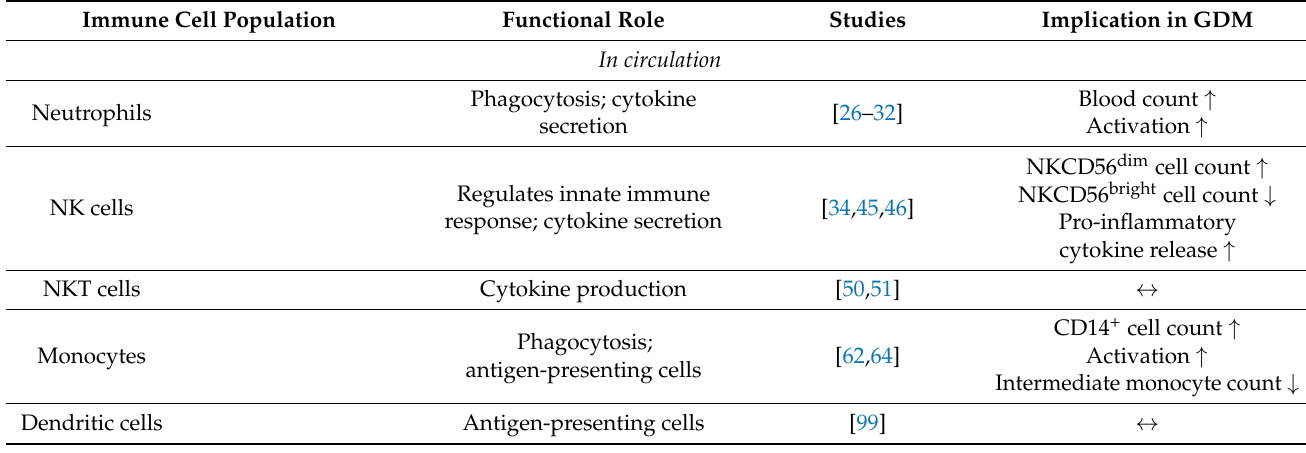
Table 1. A summary of the studies describing immune cell populations in maternal circulation, placental tissue and adipose tissue in GDM pregnancies and how their cellular function is altered in GDM relative to uncomplicated pregnancies. ↑ , increased; ↑ , decreased; ↔ , no significant change